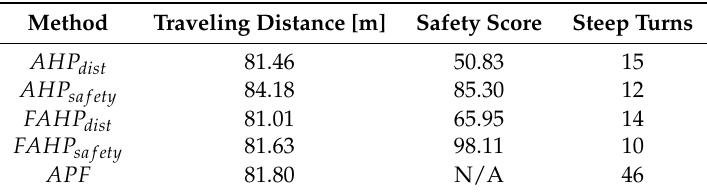
Table 8. Simulation results comparison between AHP, FAHP, and APF.